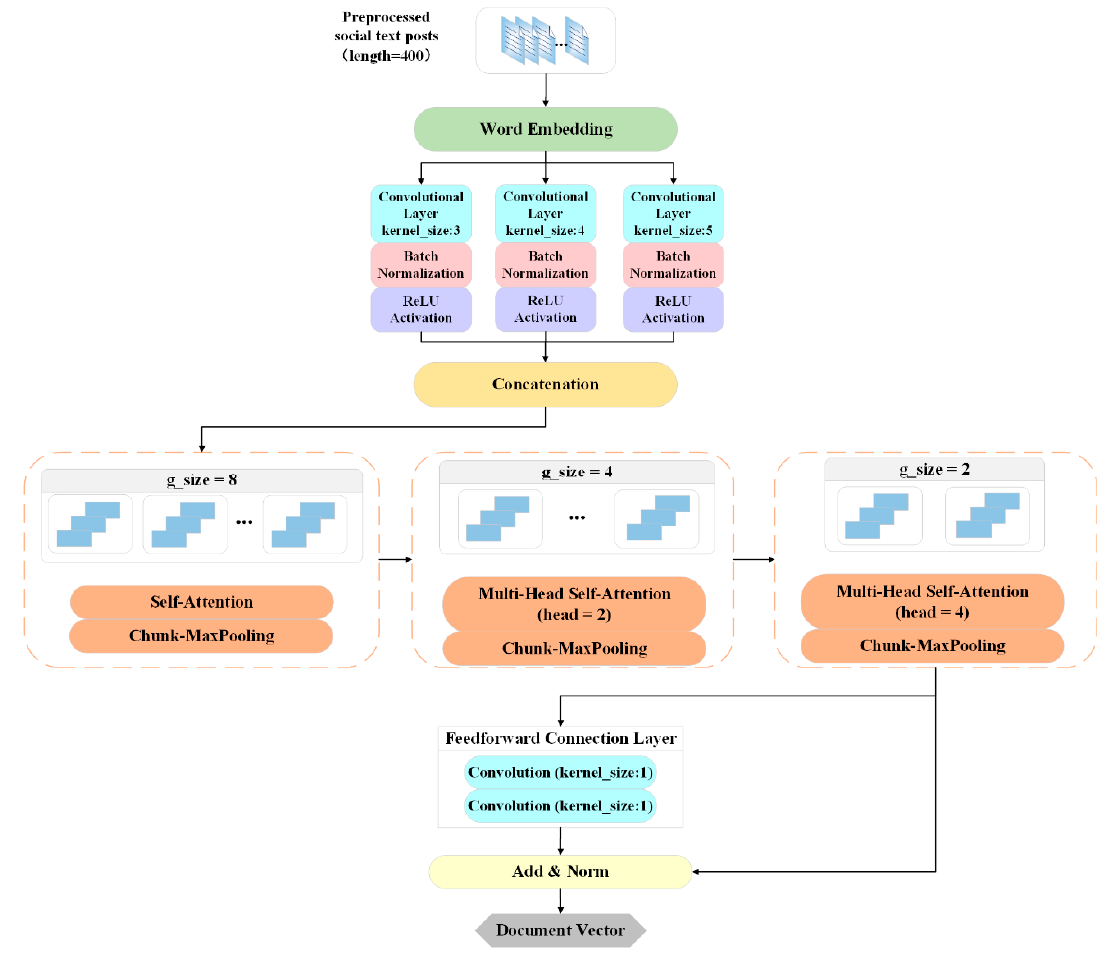
Figure 2. Architecture of HMA-CNN module.